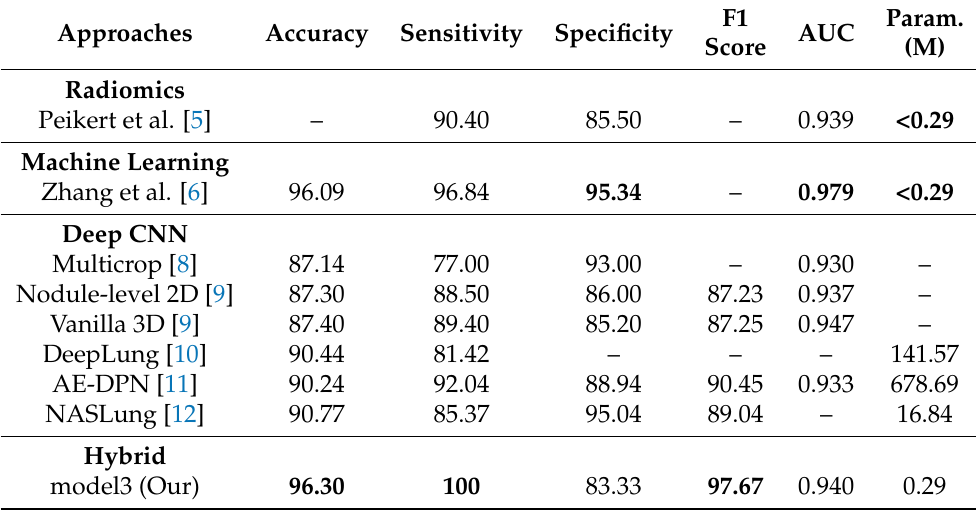
Table 9. Results of our method compared to the state of the art with malignant nodules as posi- tive